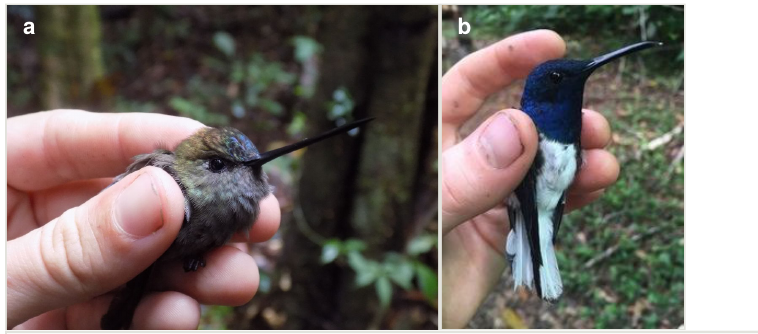
Figure 8. Representative hummingbirds captured near Pantiacolla (Manú Province, Madre de Dios Region, 400